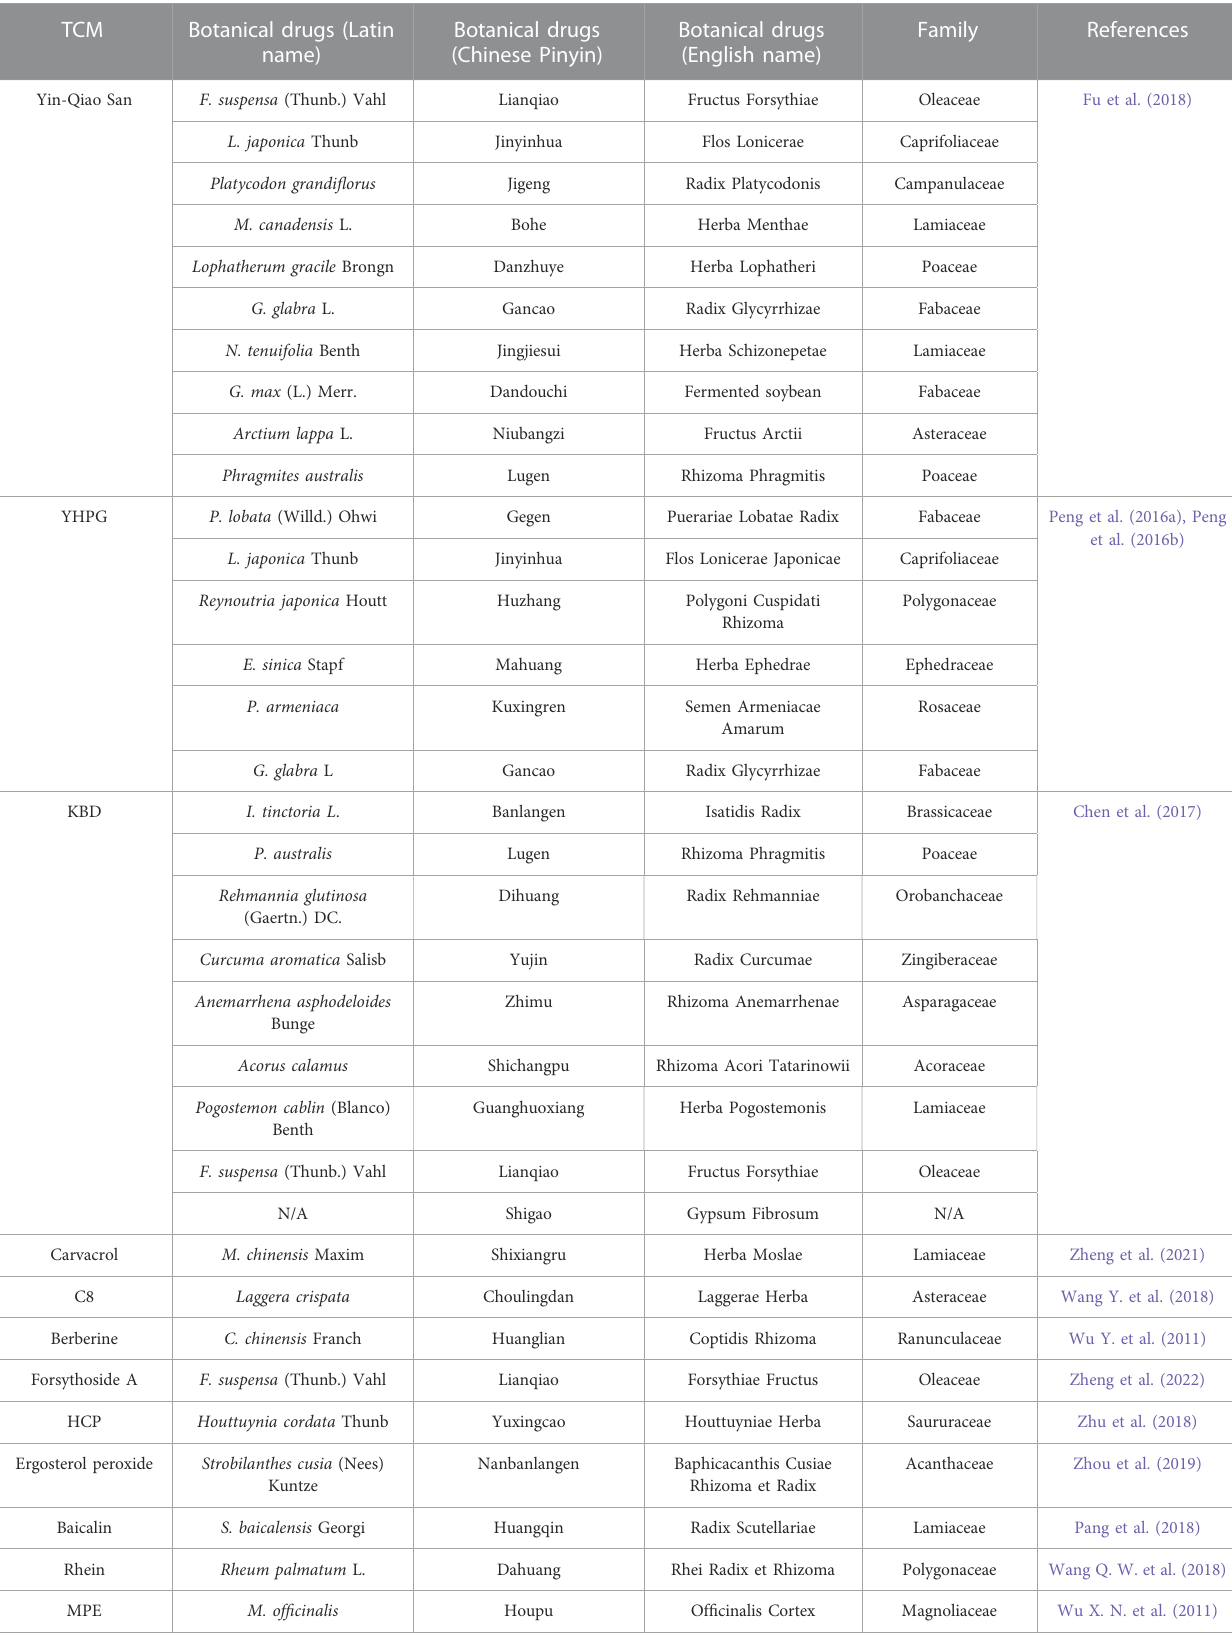
TABLE 3 ( Continued ) The composition of formulae and single-active-ingredients of